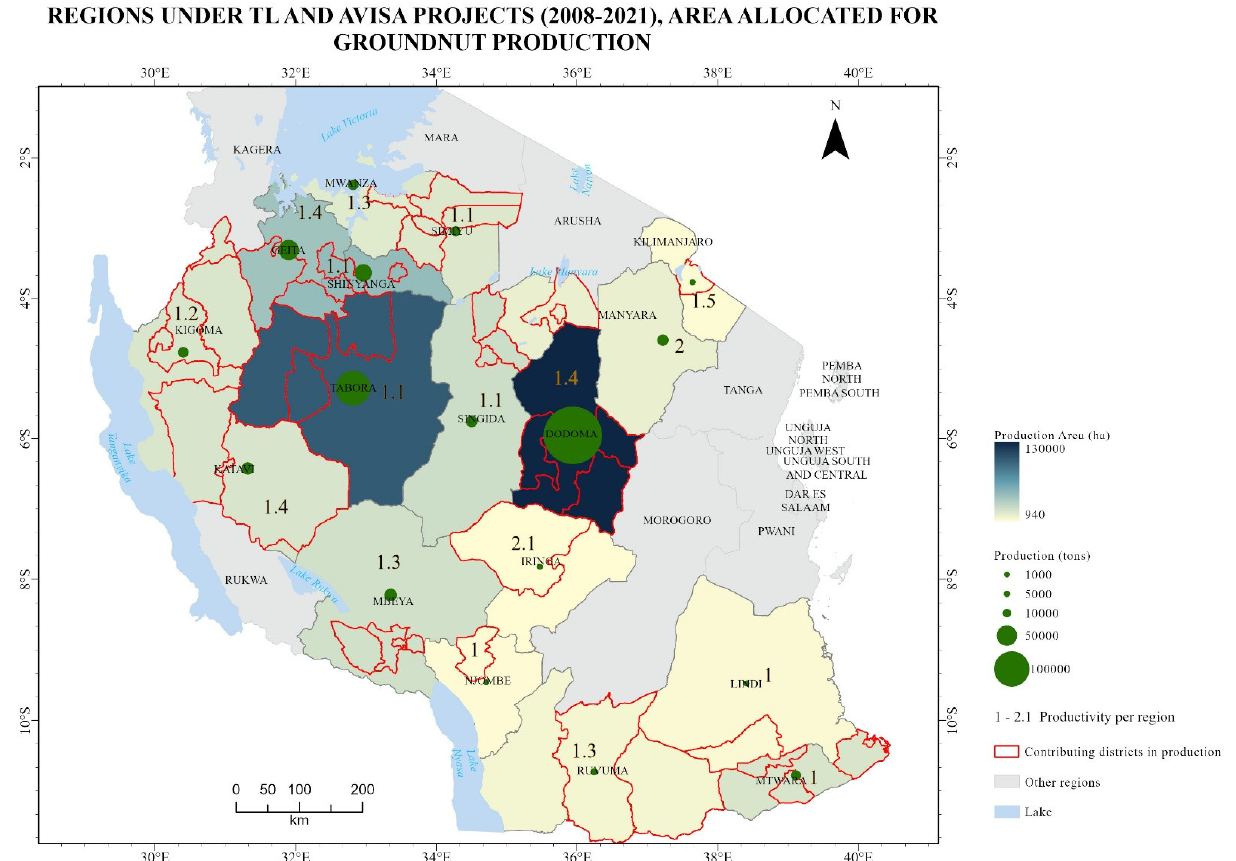
Figure 1. Map showing the project intervention areas for groundnut production in Tanzania.